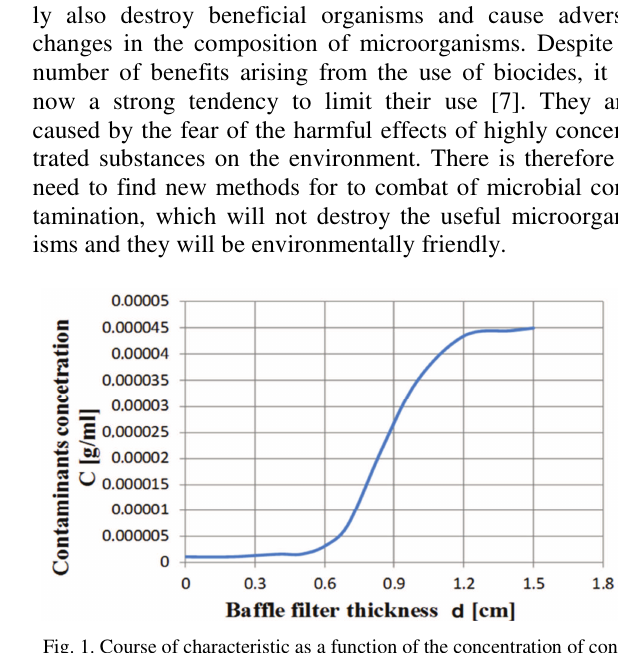
Fig. 1. Course of characteristic as a function of the concentration of con- taminants in the deposition thickness of baffle